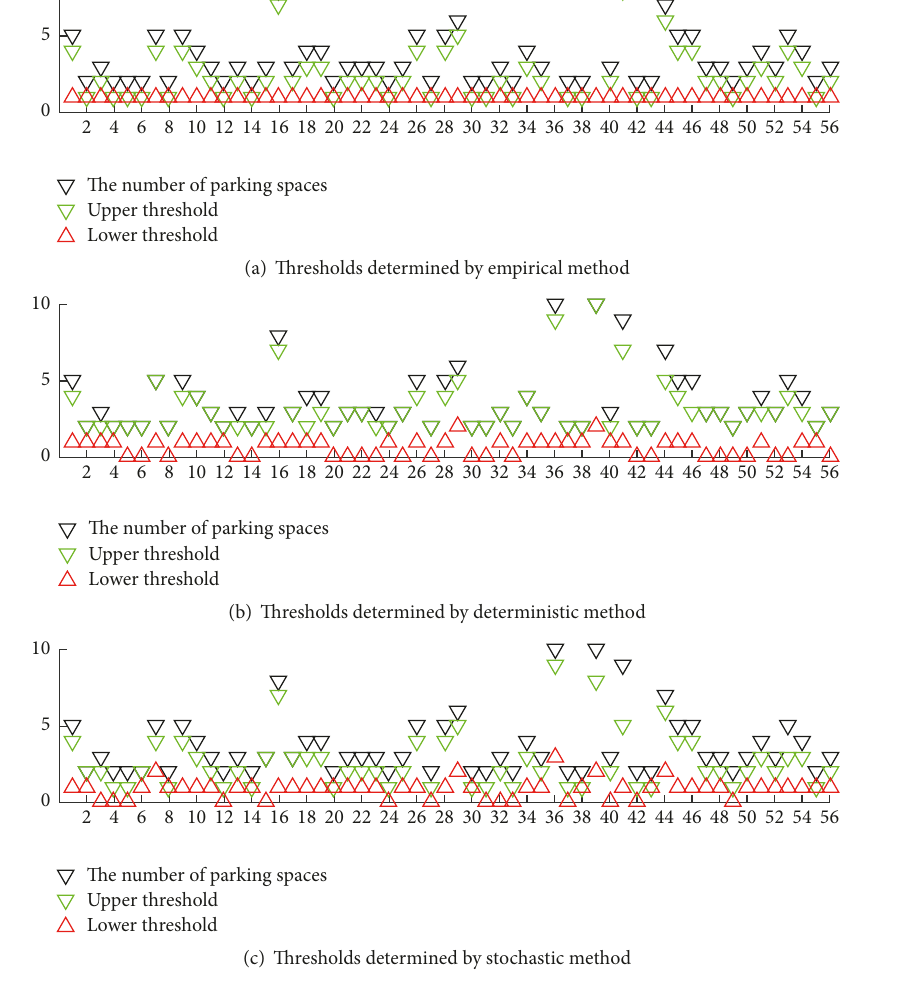
Figure 5: Result comparison among empirical method, deterministic method, and stochastic